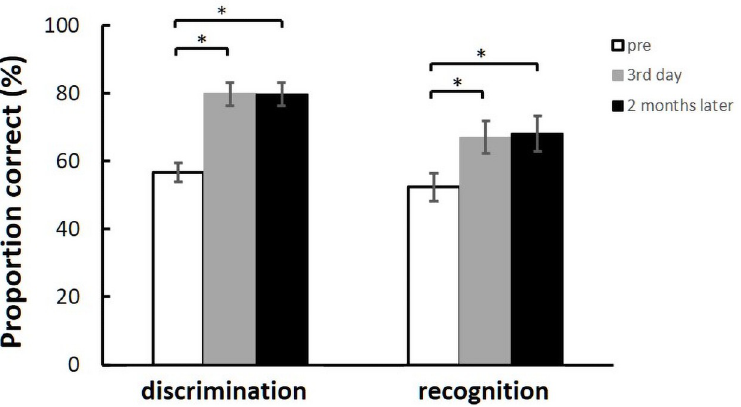
Fig 5. Average proportion of correct responses in terms of discrimination and recognition on the pre-test, third training day, and 2 months later in the NF group. Error bars for the data are SEM; � p < 0.05.